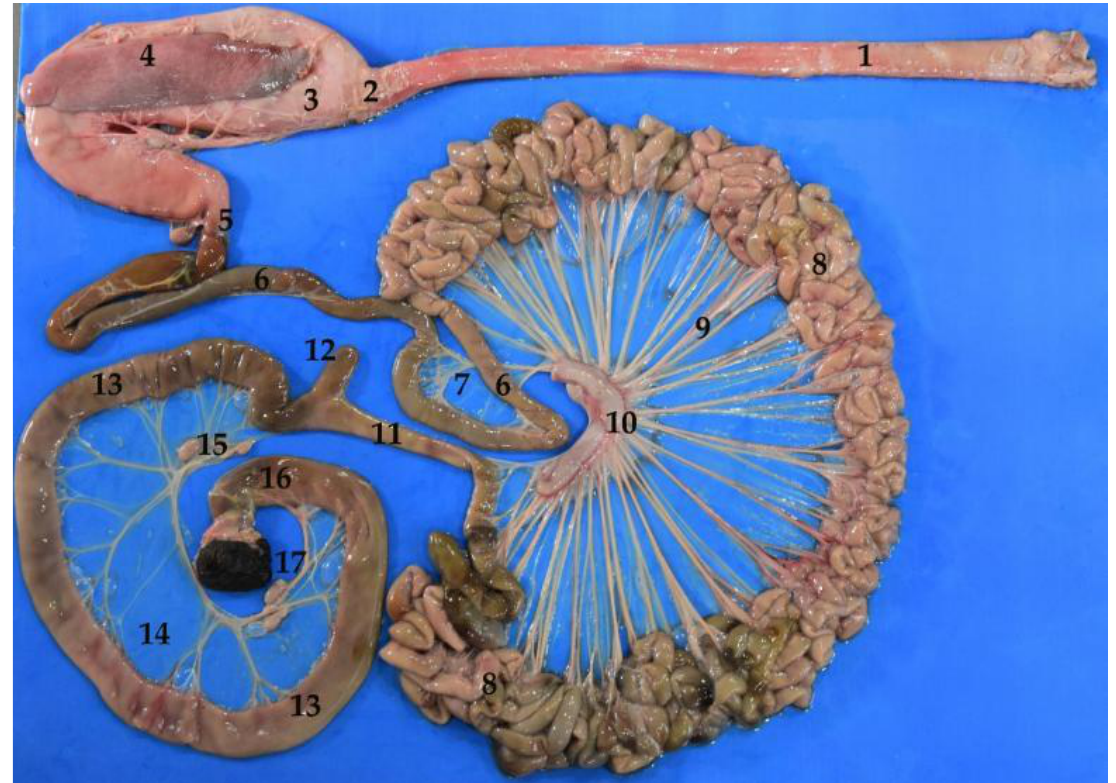
Figure 4. Isolated digestive system of the Arctocephalus australis . ( 1 ) Esophagus; ( 2 ) cardiac sphincter; ( 3 ) stomach; ( 4 ) spleen; ( 5 ) pylorus; ( 6 ) duodenum; ( 7 ) mesoduodenum; ( 8 ) jejunum; ( 9 ) mesojejunum and mesenteric vessels; ( 10 ) small intestine mesenteric lymphnodes; ( 11 ) ileum; ( 12 ) cecum; ( 13 ) colon; ( 14 ) mesocolon and mesenteric vessels; ( 15 ) large intestine mesenteric lymphnodes; ( 16 ) rectum; ( 17 ) anal canal. Table 2. Morphometric data of the Arctocephalus australis esophagus (11 specimens). A: adult; J: ju- venile.